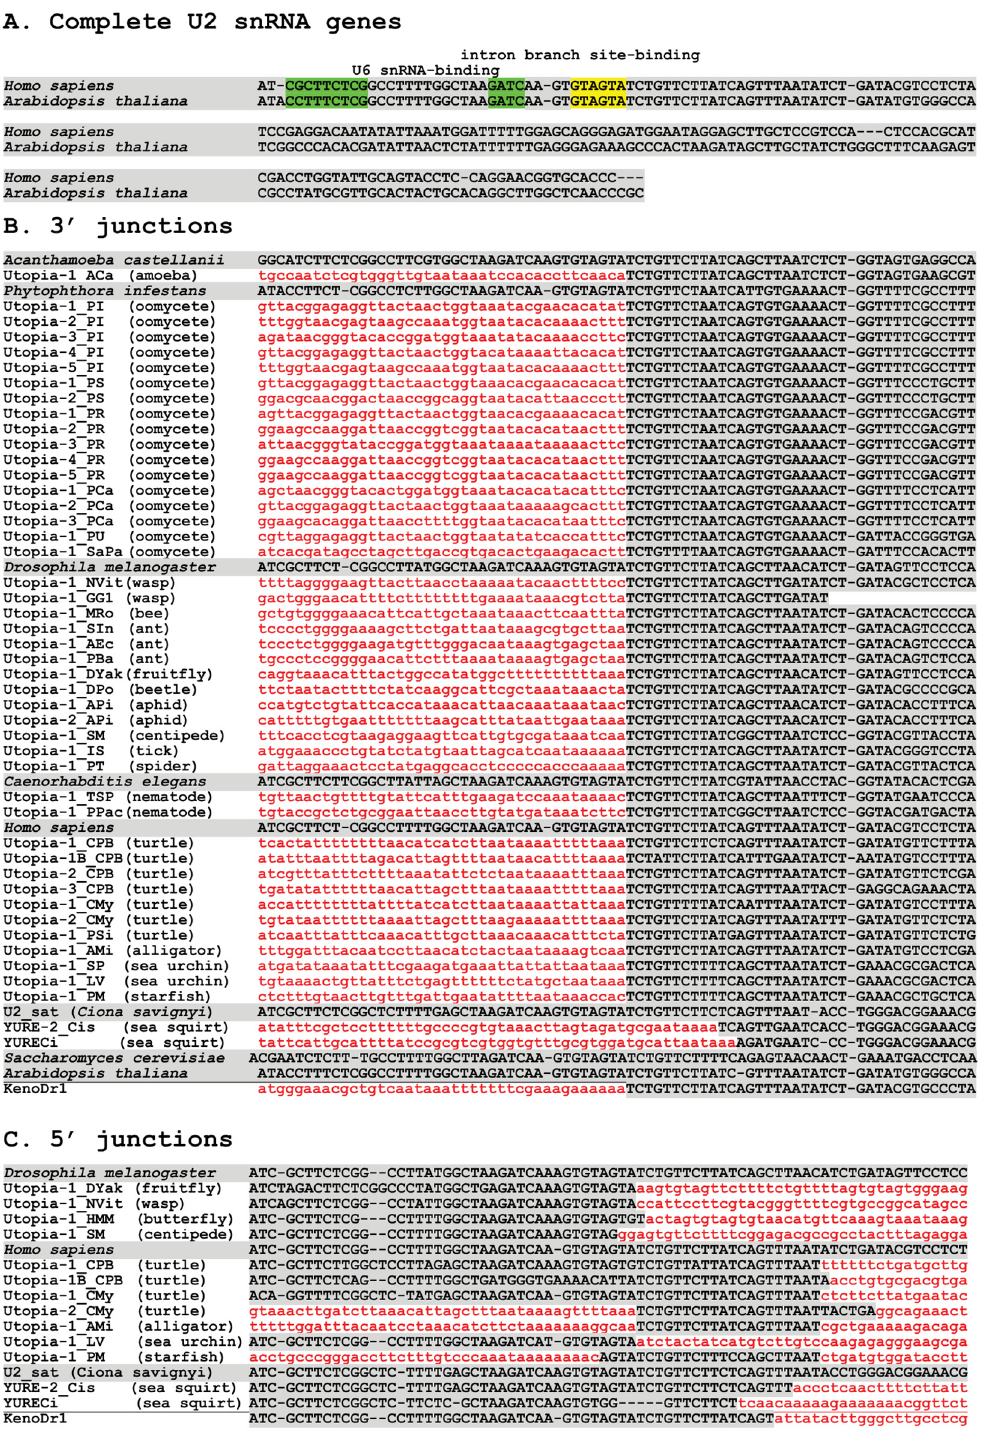
Fig 1. Junction sequences of Utopia elements and U2 snRNA genes. Utopia sequences are in lowercase and red-colored while U2 gene sequences are in uppercase and shaded. Utopia sequences are either the consensus or a representative flanked with U2 genes. (A) Complete U2 snRNA genes for human and Arabidopsis thaliana . These two genes are shown because they are annotated as full-length and represent the diversity of 3 ’ regions. Functionally important sequences are highlighted: U6 snRNA-binding, green; intron branch site-binding, yellow. (B) Comparison of 3 ’ junctions. (C) Comparison of 5 ’